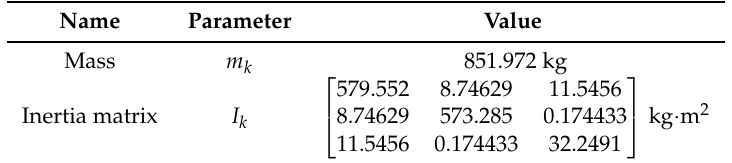
Figure 7. Knuckle boom center of mass. Table 2. Knuckle boom